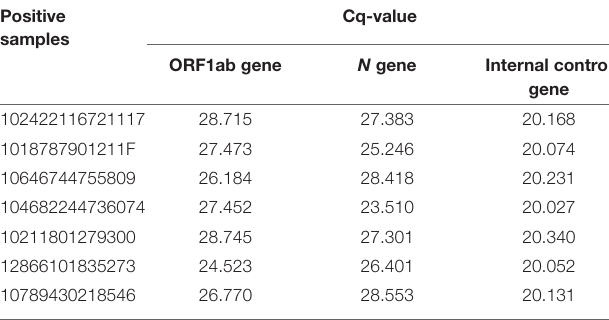
TABLE 4 | The Cq-value of positive samples. Positive